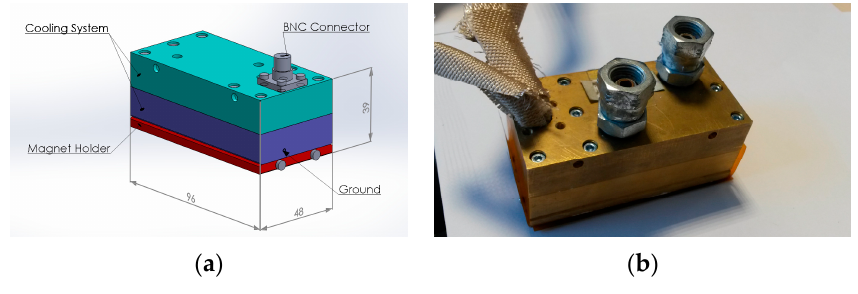
Figure 7. ( a ) EMAT design; ( b ) EMAT prototype.